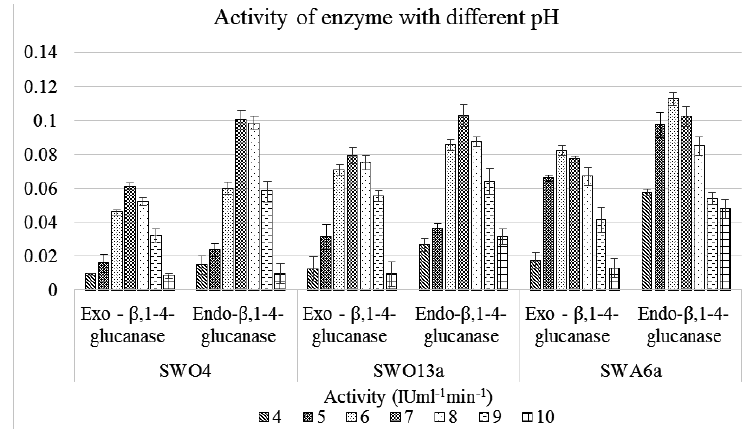
Fig. 1. Graphical representation of the variation of activity of Endo- β - 1,4 glucanase and Exo- β - 1,4 glucanase of the three Strains with varying pH ranging from pH 4